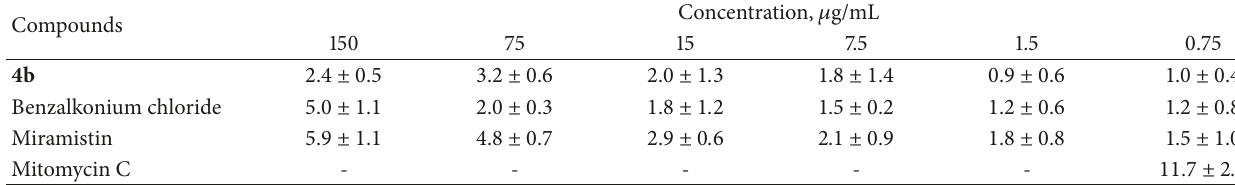
Table 4: DNA-damage activity of 4b in SOS-chromotest (ratio, fold increase over the solvent control). Compounds